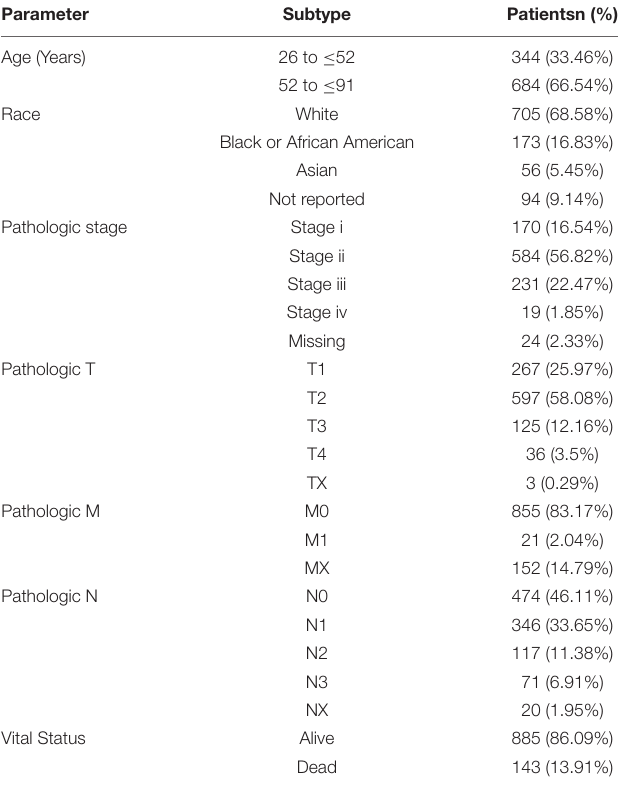
TABLE 1 | Clinical pathological characteristics of 1,028 patients with breast cancer.